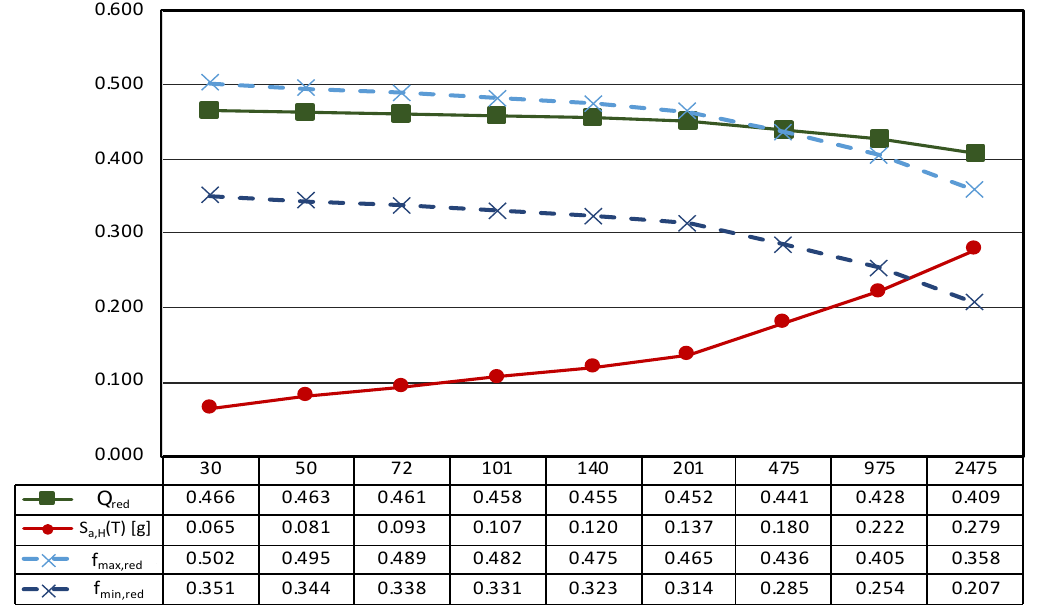
Figure 13. Results of the seismic performance assessment of the Mater Matuta under generalized ground shaking.